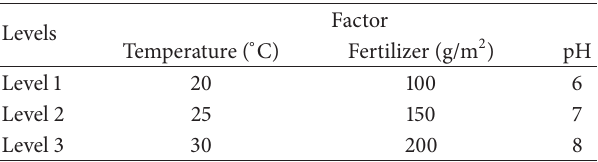
Table 1: Experimental design with three factors and three levels per factor.